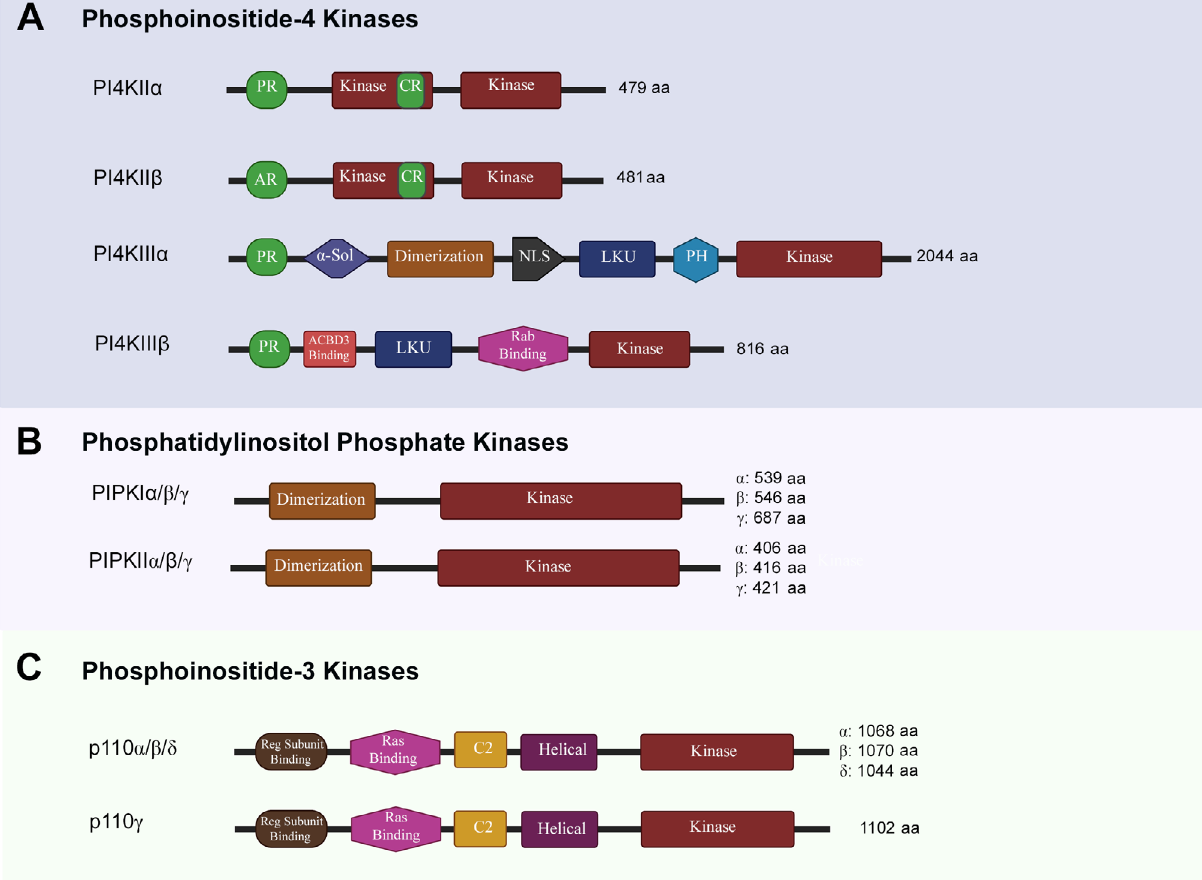
Figure 2. Structural features of phosphoinositide kinases. aa: amino acid; α-Sol: α-solenoid domain; NLS: nuclear localization signal; LKU: lipid kinase unique; PH: pleckstrin homology domain; ACBD3: acyl-CoA-binding protein 3; Reg: regulatory.